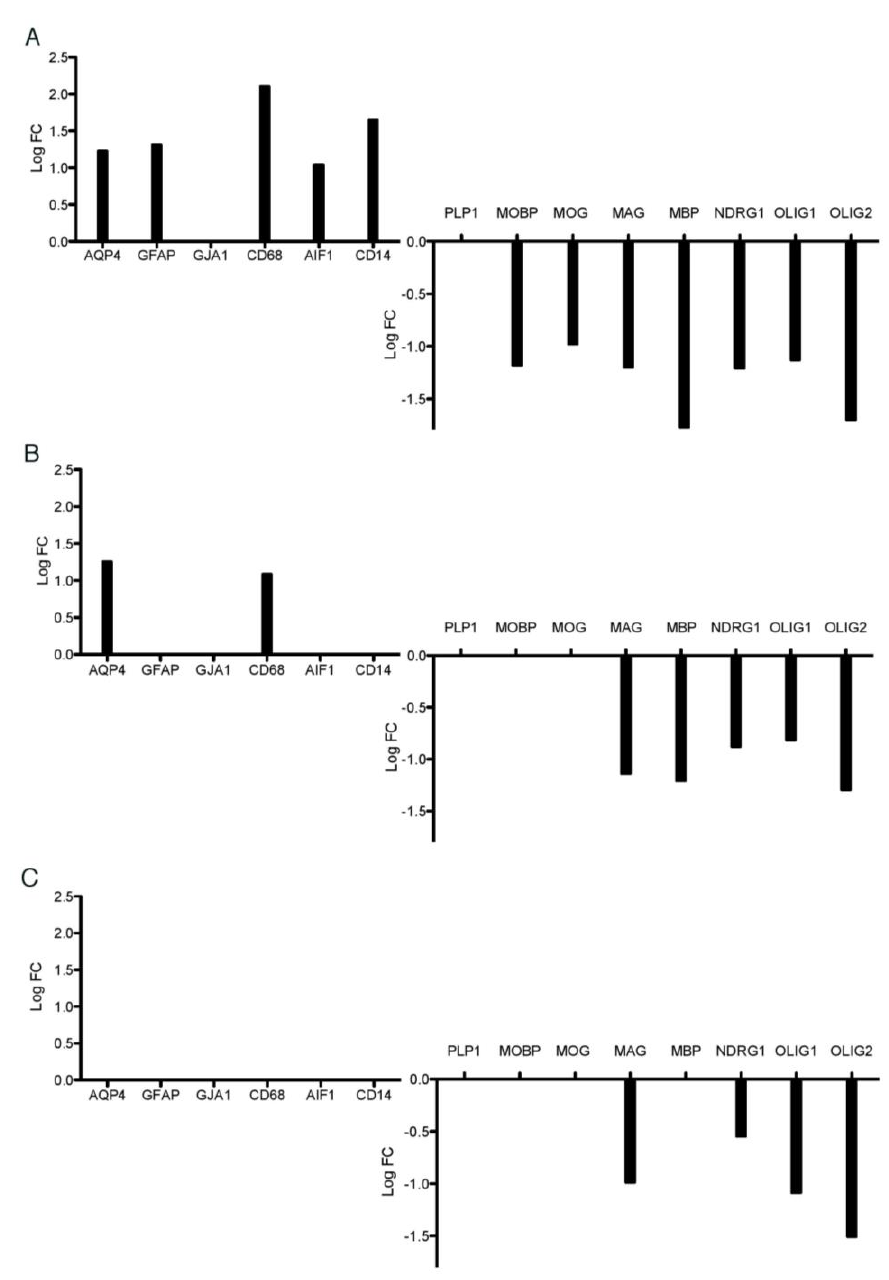
Figure 1. Differential expression of key astrocyte, microglial and oligodendrocyte genes in rims and periplaques compared with control white matter.